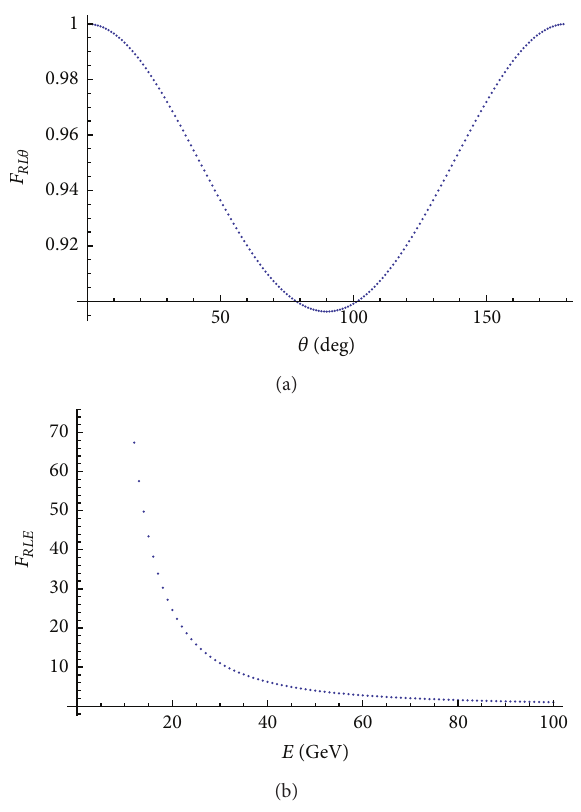
Figure 26: The variation of (a) 𝐹 𝑅𝐿𝜃 (𝐸,𝜃) , defined in the text with 𝜃 for 𝐸 = 3 GeV, (b) with 𝐸 for 𝜃 = 𝜋/4 for virtual light partons (colour online). The results displayed in this figure are evaluated for vanishing quark mass, 𝛽 = 0.95 , and emitted gluon energy, 𝑘 0 = 10 MeV. The quark virtuality is defined as 𝑉 2 = 𝐸 2 (1 − 𝛽 2 ) .